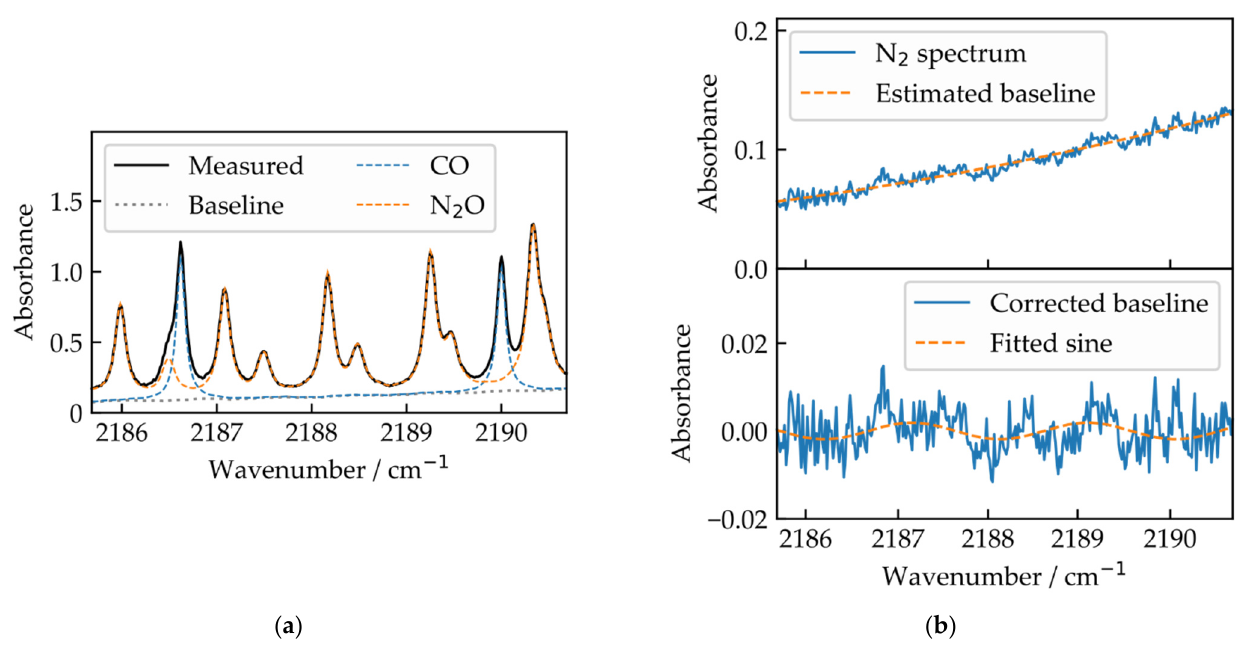
Figure 2. ( a ) measured absorbance spectrum of a gas sample with target gas concentrations of 30 ppm for CO and 50 ppm for N 2 O. The spectrum is recorded with a dual comb spectrometer comprising 301 spectral elements separated by 0.017 cm − 1 ; ( b ) exemplary measured nitrogen spectrum, which is not infrared-active. From these, the spectrometer influence on the measured absorbance spectrum is estimated by fitting and subsequent normalization using a polynomial function (top) and additional sine functions (bottom) to model optical fringes.